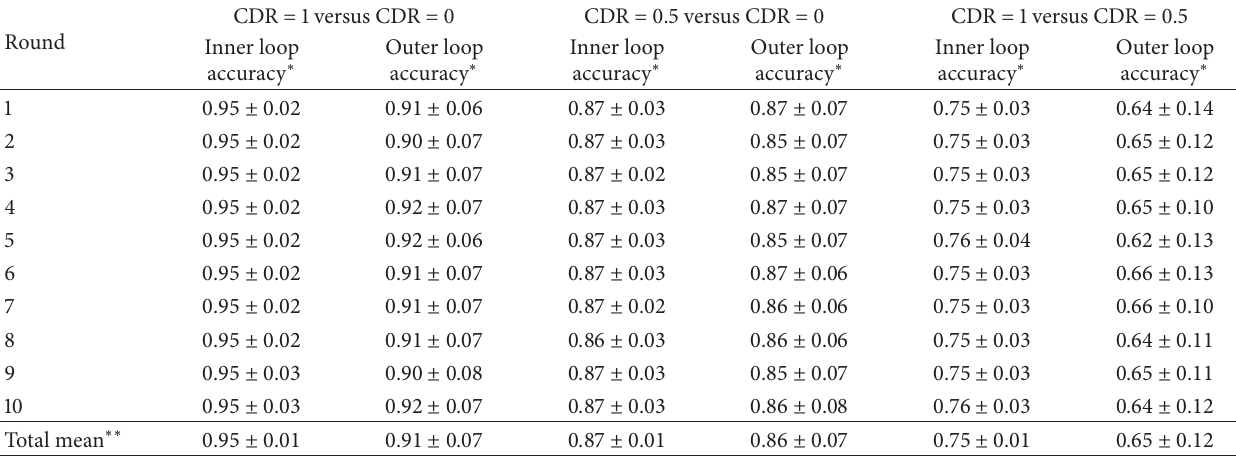
Table 6: Performance of ML (accuracy) in the inner and outer loops for each of the 10 rounds (averaged across 100 iterations). Results are reported for CDR = 1 versus CDR = 0, CDR = 0.5 versus CDR = 0, and CDR = 1 versus CDR = 0.5 using a linear kernel and the computation- based feature reduction.